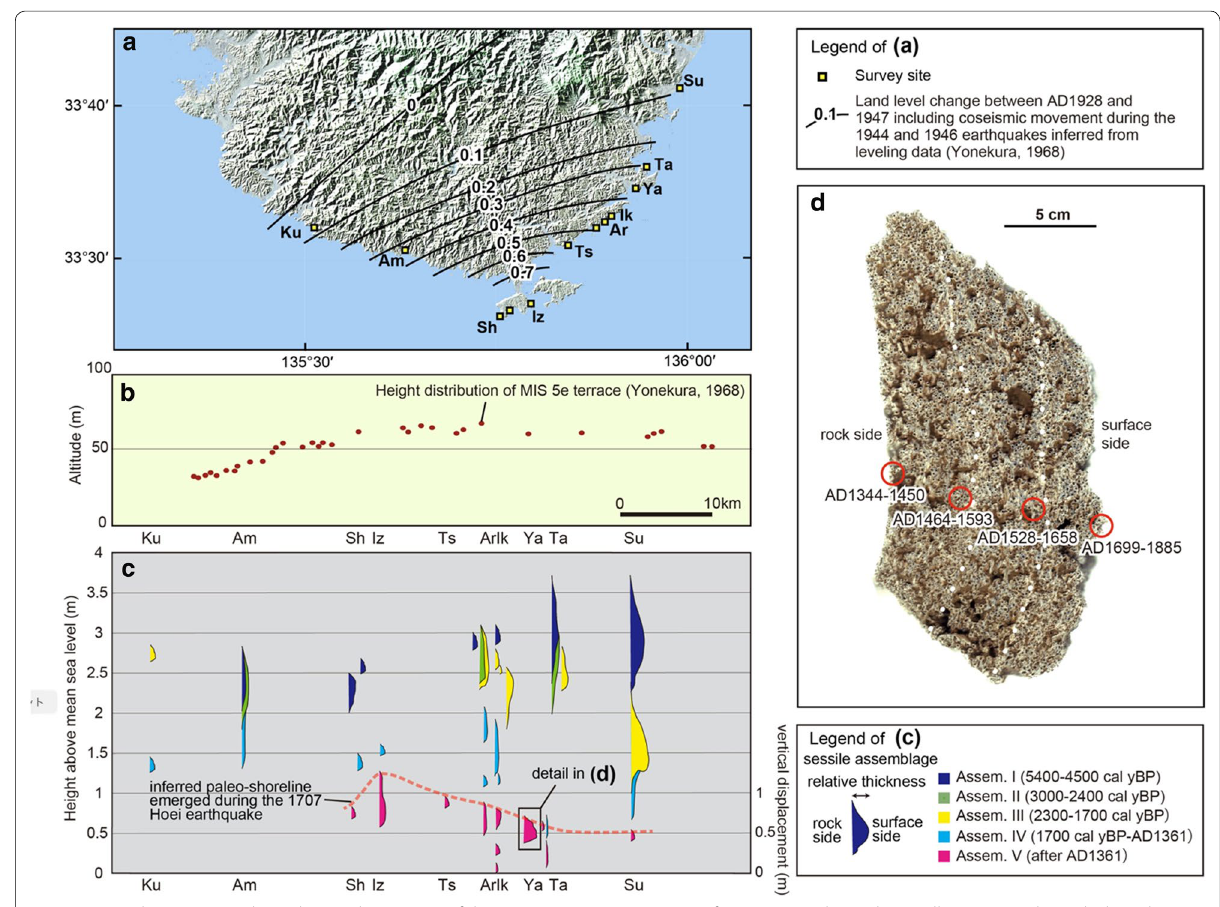
Fig. 5 Vertical movement along the southern coast of the Kii Mountains. a Location of survey sites shown by small squares with symbols and coseismic vertical movements during the 1944 and 1946 Showa earthquakes by black solid lines in meter. b Height distribution of the MIS 5e terrace (Yonekura 1968). Symbols at the bottom indicate locations shown in a . c Height distribution of emergent fossil assemblages. Symbols at the bottom indicate locations shown in a (revised from Shishikura et al. 2008). d Photo of a vertical slice from fossil assemblage shown in c . Red circles are positions of 14 C age samples. White dotted lines indicate discontinuous